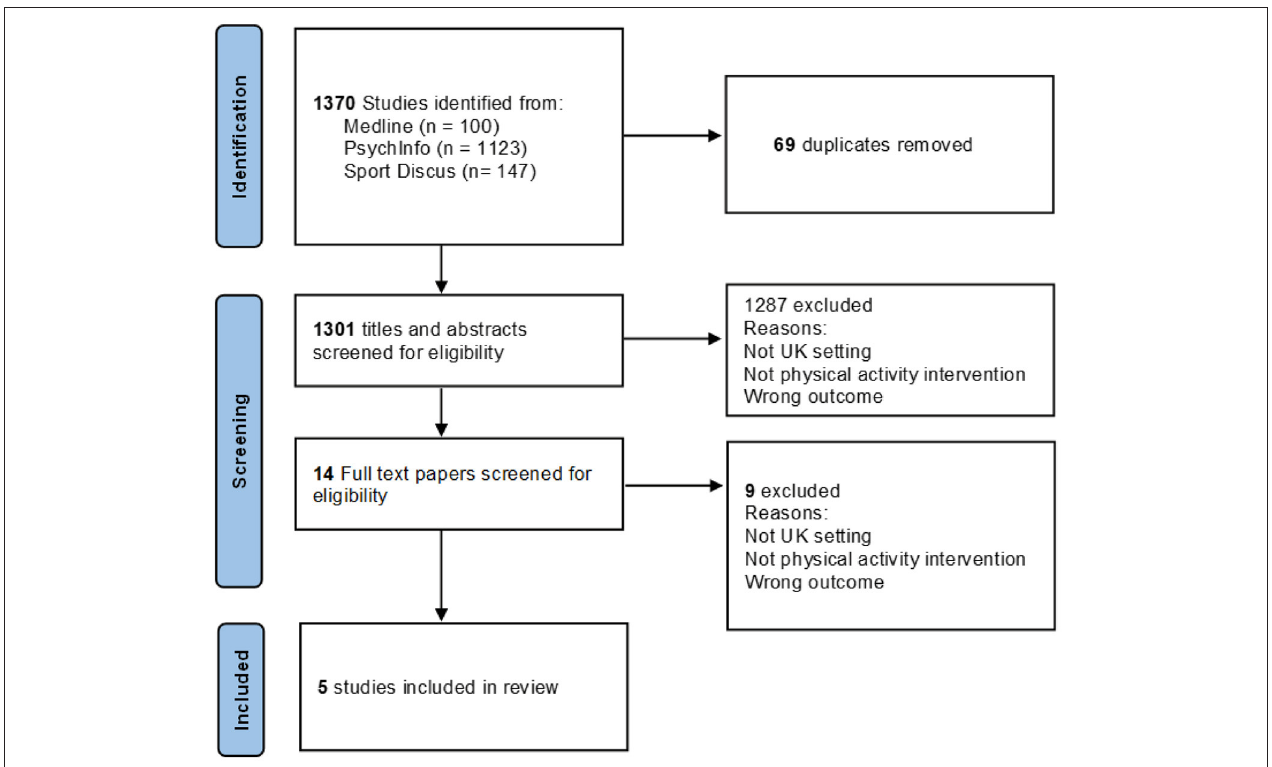
FIGURE 1 | Flowchart documenting the study selection process for the